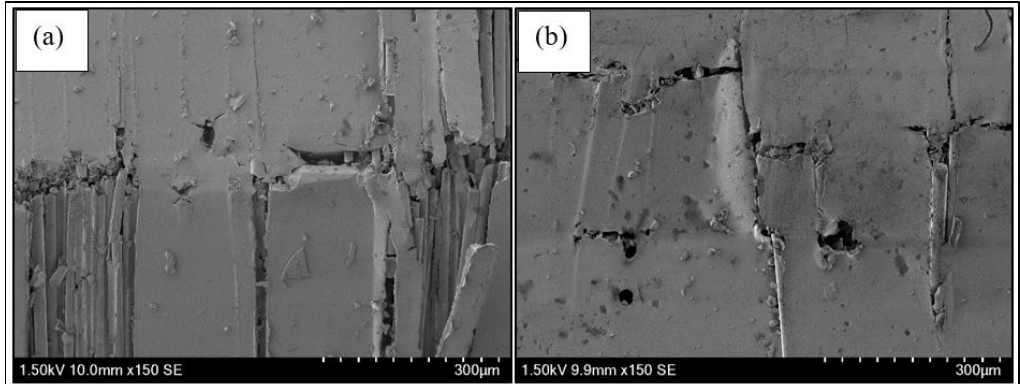
Figure 4. SEM micrographs showing the tensile damage specimens of ( a ) unmodified BF and ( b ) BF-H0.1 composites.